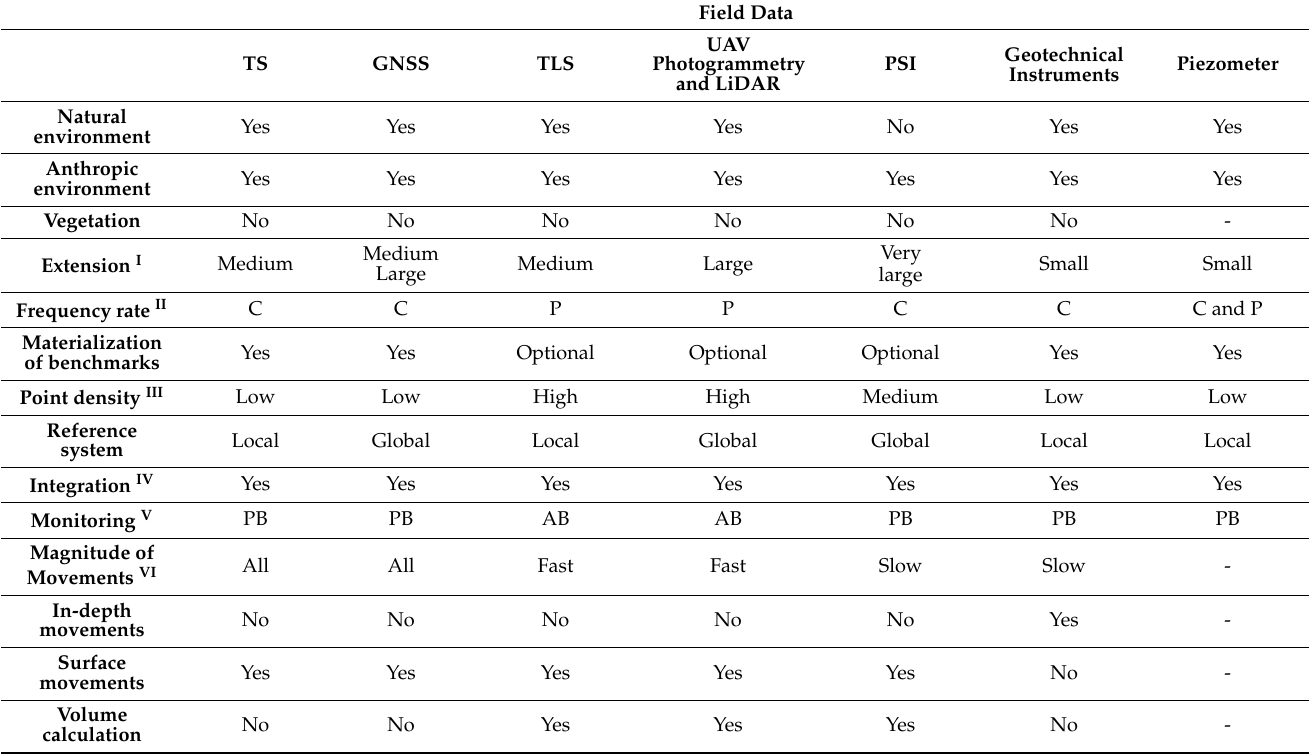
Table 1. Specifications of techniques for field data